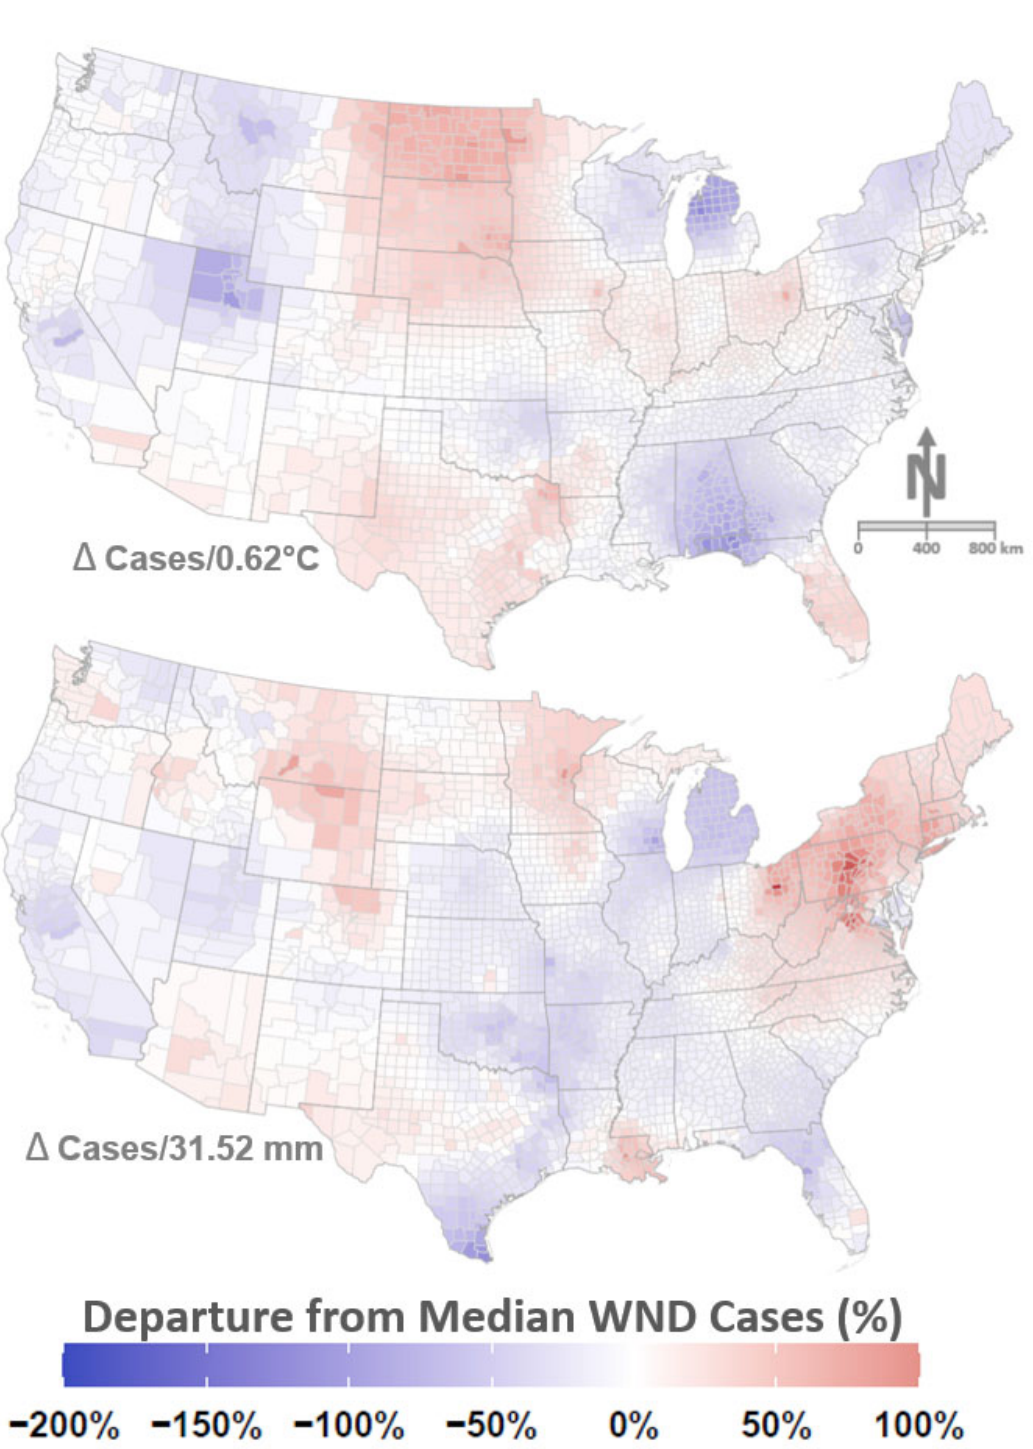
Figure 6. Spatially varying coefficients (SVCs) for climate. Maps show SVCs for temperature ( top ) and precipitation ( bottom ) by US County. Mapped colors correspond to legend at bottom and are scaled to show relative change (%) in equine WND cases with respect to the median case rate of 3.88 (1.83, 6.67 CI) cases/100,000 horses. Warm colors (reds) highlight locations where above average temperature (per 0.62 ◦ C anomaly) and precipitation (per 31.52 mm anomaly) correlate to increased WND cases. Cooler colors (blues) indicate locations where above average temperature and precipitation correlate with decreased WND cases. Areas shown in white signify locations with little change in WND cases as temperature or precipitation